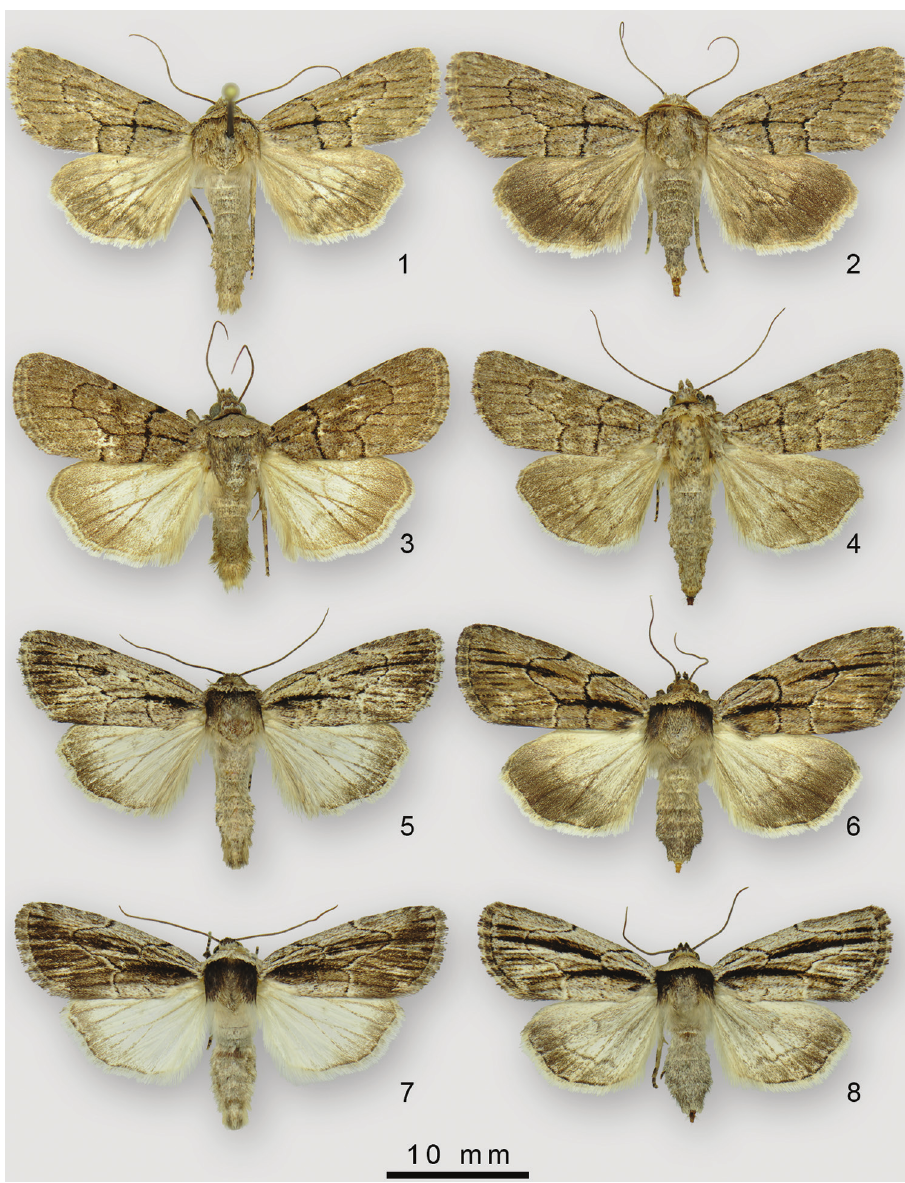
Figures 1–8. 1 Sympistis eleaner male (holotype) 2 S. eleaner female (paratype) 3 S. induta male 4 S. induta female 5 S. tenuistriga male 6 S. tenuistriga female 7 S. badistriga male 8 S. badistriga female. of sclerotized portion of A8; lamella antevaginalis weakly sclerotized and unmodified; ostium forming a rounded cone, slightly longer than wide; appendix bursae pear shaped, with ductus seminalis originating at anterior end and directed caudad; corpus bursae reduced to a small, polyp-like vesicle attached to right side of main bursa